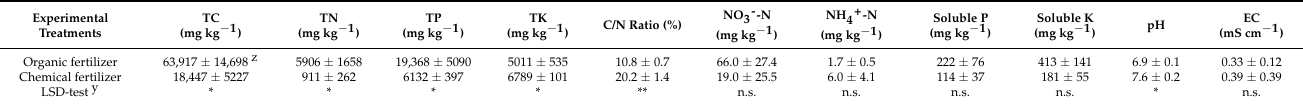
Table 3. Chemical properties of soils of orchards under organic and chemical fertilizer management systems. Experimental Treatments Organicfertilizer